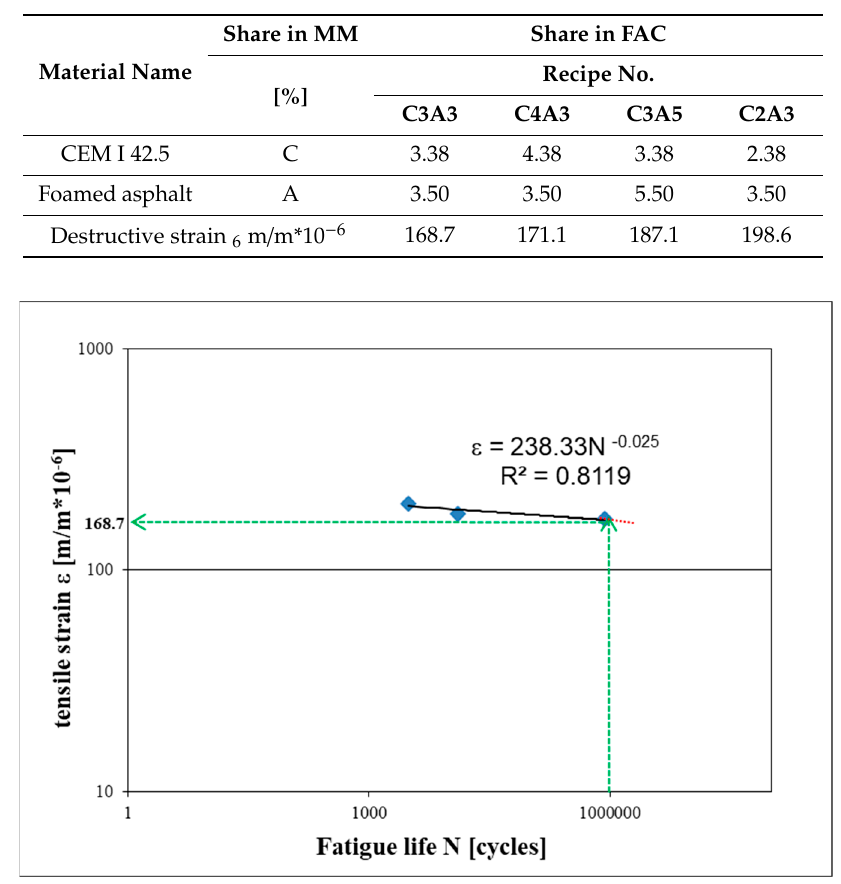
Figure 6. The course of the FAC mixture fatigue test at standard load.